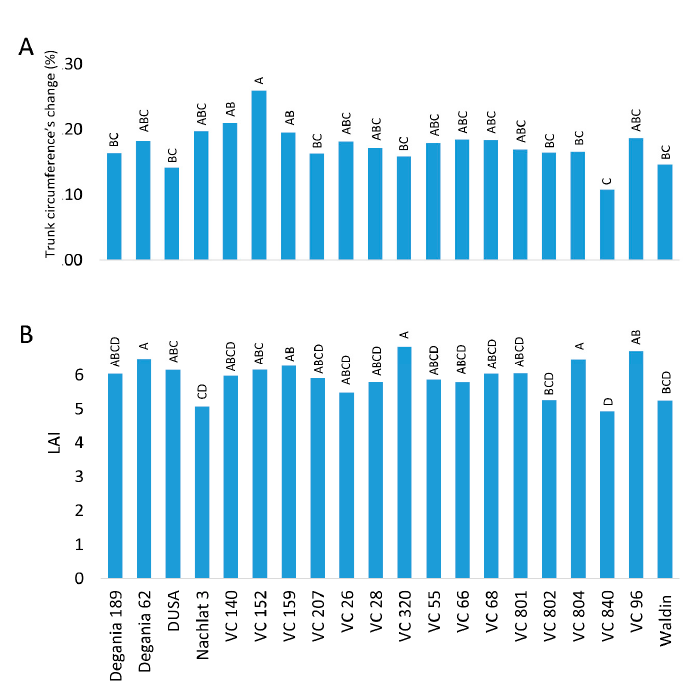
Figure 4. Vegetation indices of ‘Hass’ avocado trees grafted onto various rootstocks. ( A ): the relative change in trunk circumference from 2018 to 2020 (under salinity conditions). ( B ): leaf area index (LAI) measured in August 2020. Different letters represent significant ( p ≤ 0.05) differences between rootstocks. SD values are presented in Table S1. Plants 2021 , 10 , x FOR PEER REVIEW Photosynthesis rates were affected by the rootstock (Figure 5). The highest stomatal conductance ( g s) was measured in leaves of VC 152 (Figure 5A). The lowest g s values were measured in Nachlat 3, VC 802, and VC 96 were nearly half the value of highest. Similar results were found regarding CO 2 assimilation (Figure 5B).